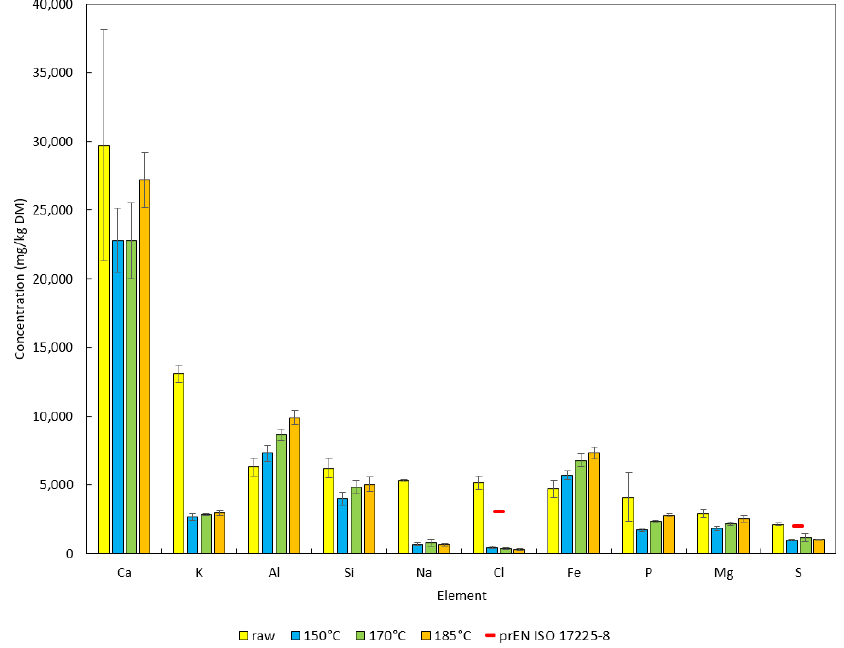
Figure 3. Mean values ± standard deviation of raw and treated (biochars) organic fraction of municipal solid waste (OFMSW) for elements with concentrations >1000 mg/kg dry matter (DM) and legal limits for fuels according to prEN ISO 17225-8:2016 [46].